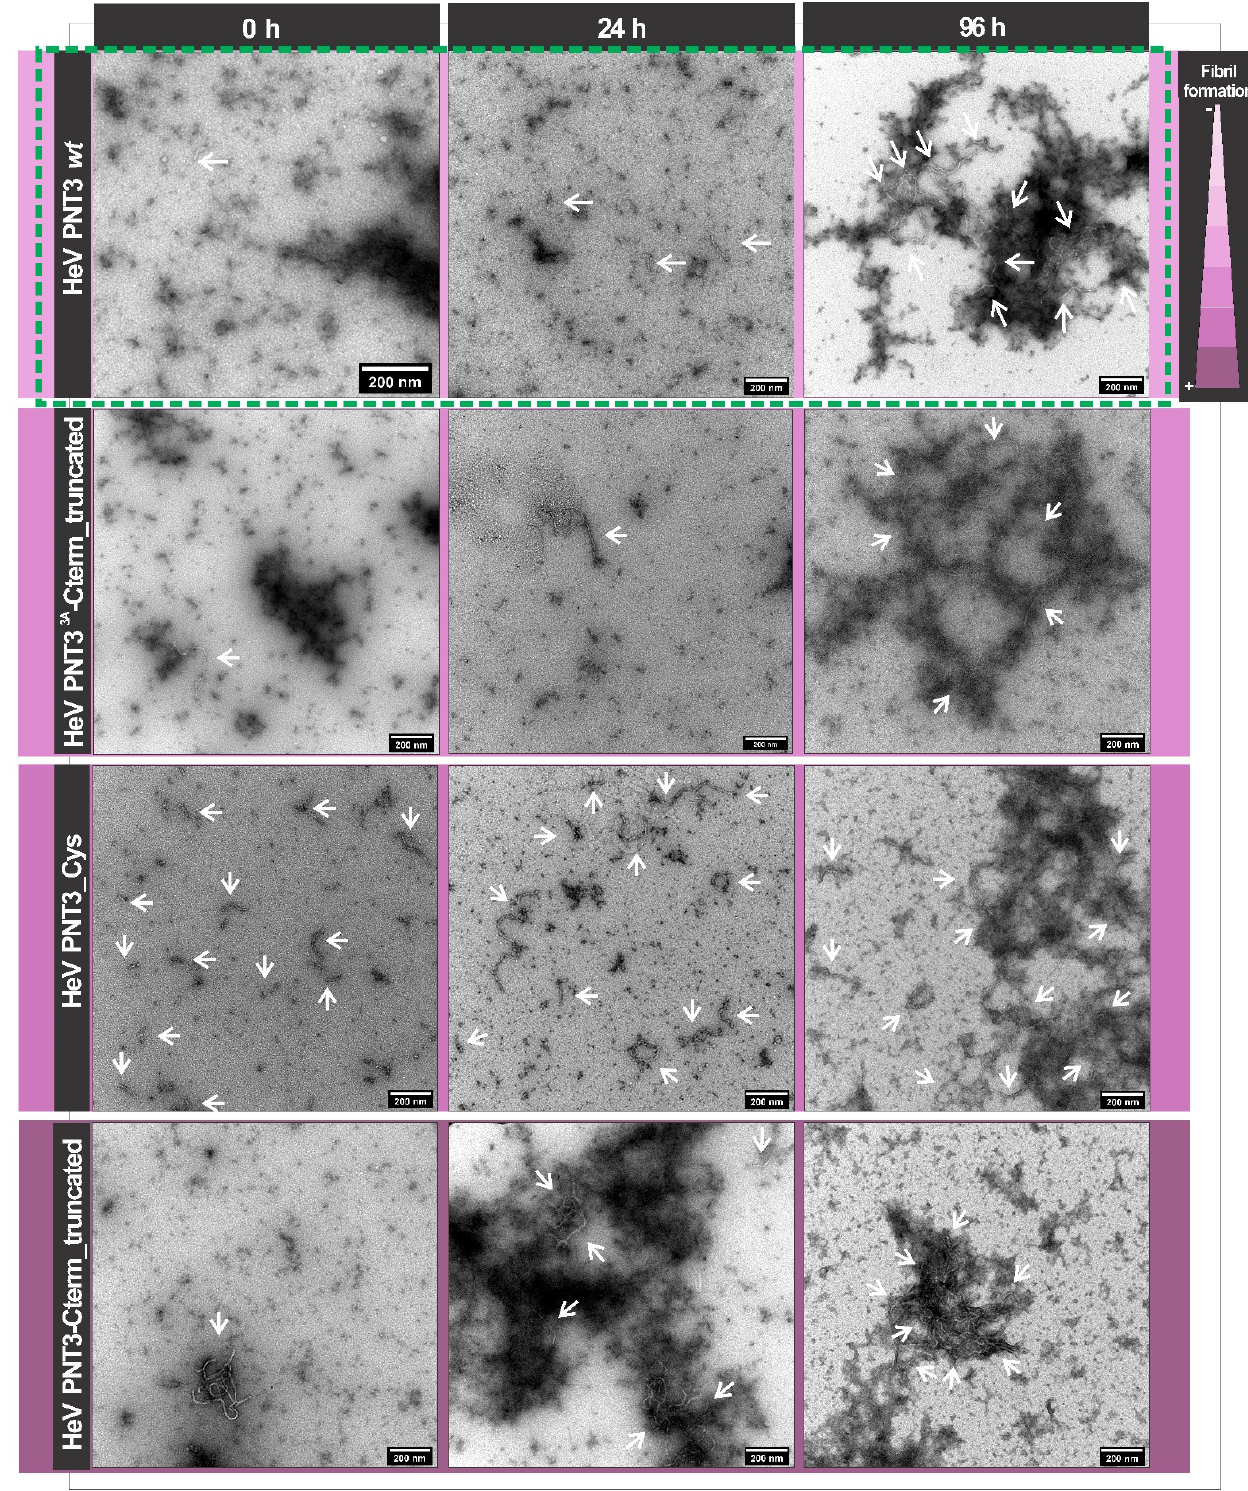
Figure 6. Fibril formation as a function of time by ns-TEM. Ns-TEM analysis of PNT3 variants (200 μ M) at time zero and after 24 h or 96 h of incubation at 37 °C. Note that in all cases, samples were diluted to 40 μ M prior to being deposited on the grid. White arrows indicate fibrils. The purple gradient represents the propensity to form fibrils. The green dashed box indicates HeV PNT3 wt results.